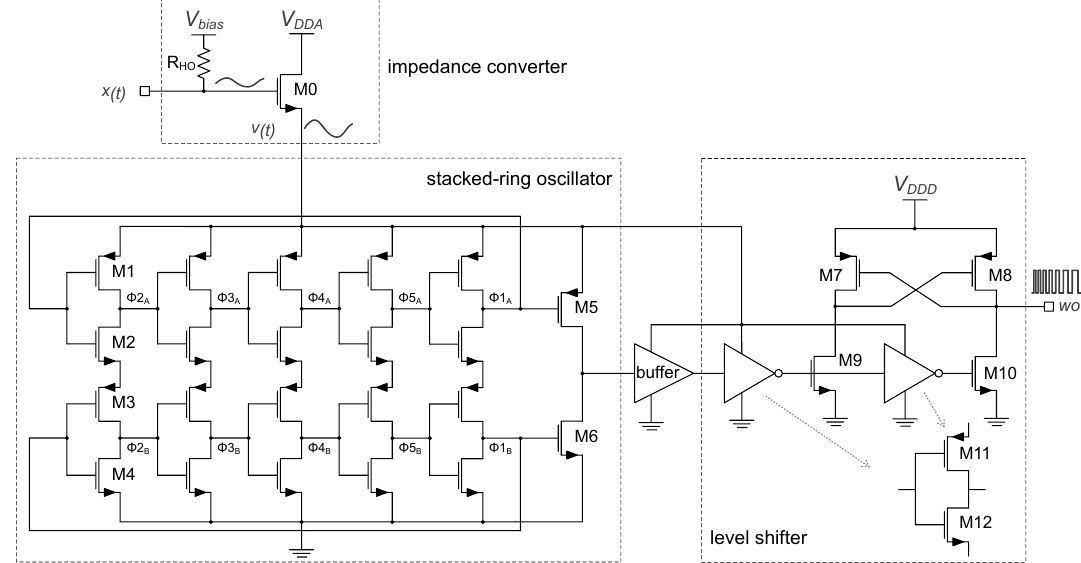
Figure 8. Single-ended analog core of the proposed VCO-ADC: Impedance converter, 5-stage stacked-RO, and differential cascade voltage switch level